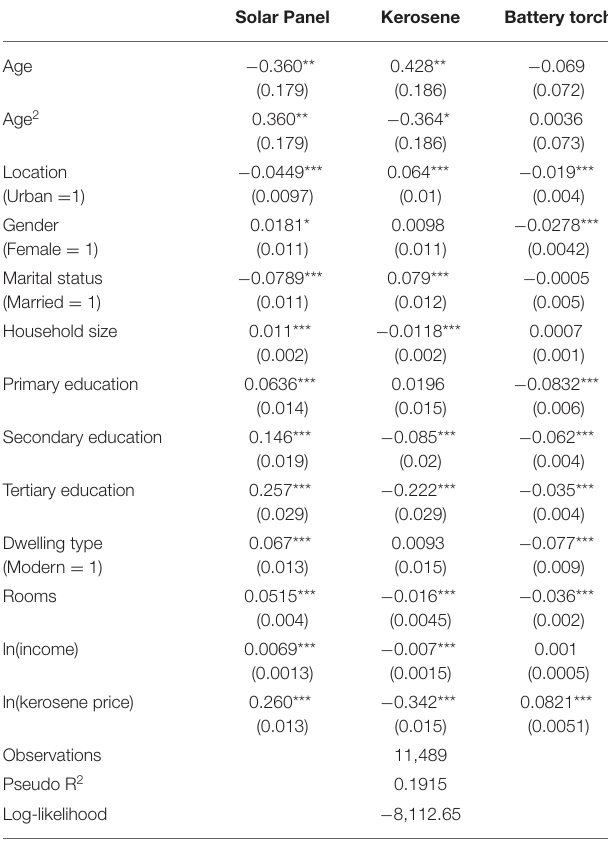
TABLE 4 | Average marginal effects of household lighting fuel choice (No grid